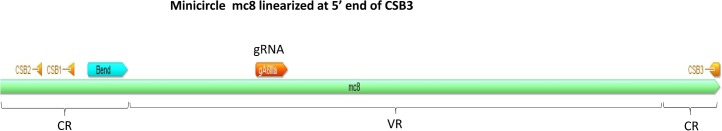
Representative linearized minicircle from L. tarentolae showing several characteristic features.The mc8 minicircle is linearized at the 5’ end of the CSB3 sequence. The “bend” region is a sequence-dependent distortion of the double helix. The encoded gRNA is annotated and is located at a characteristic distance from the CSB3. The 5'-3' polarities of the three CSB sequences, the bend and the gRNA are indicated by arrows. VR indicates Variable Region, CR indicates Conserved Region.